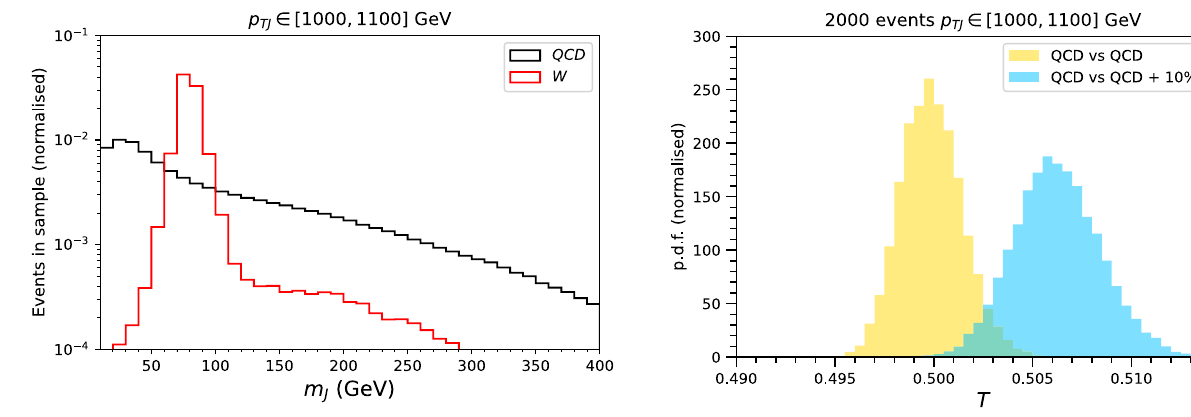
Fig. 3 Probabilitydensityfunctionsfortheestimator T ,fortwoequiv- alent QCD jet samples (yellow) or with a small contamination of W jets (blue). See the text for details